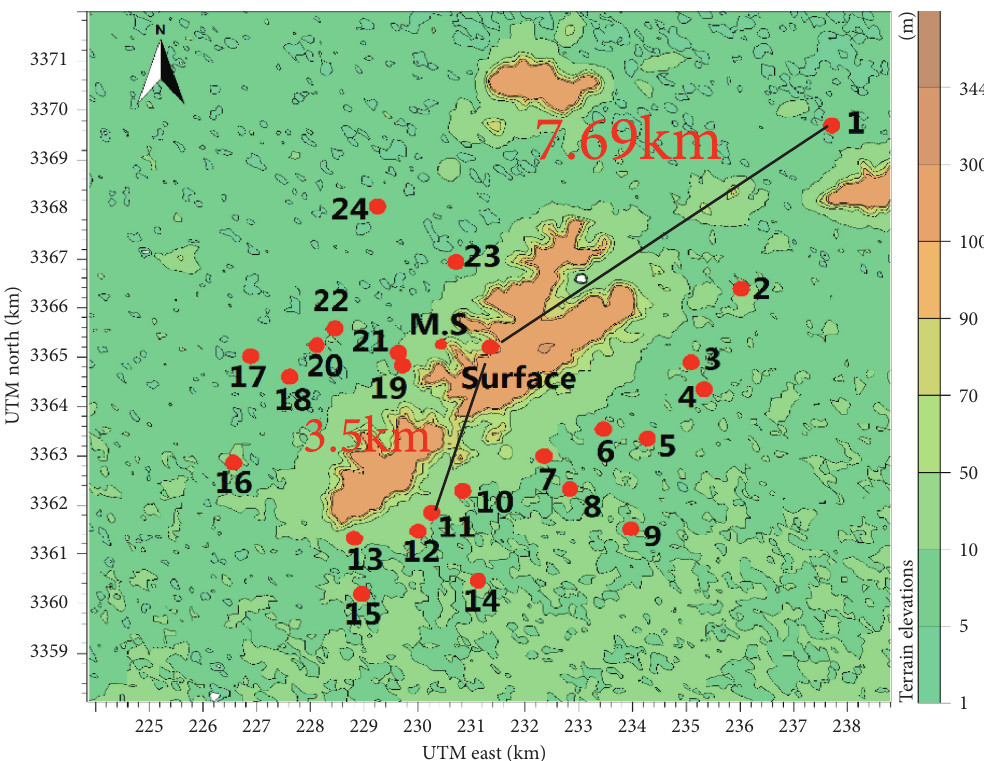
Figure 3: The distribution of the complained point (the numbers denote the different position; surface denotes the landfill working area and the origin of odor emission; MS denotes the meteorological station in the